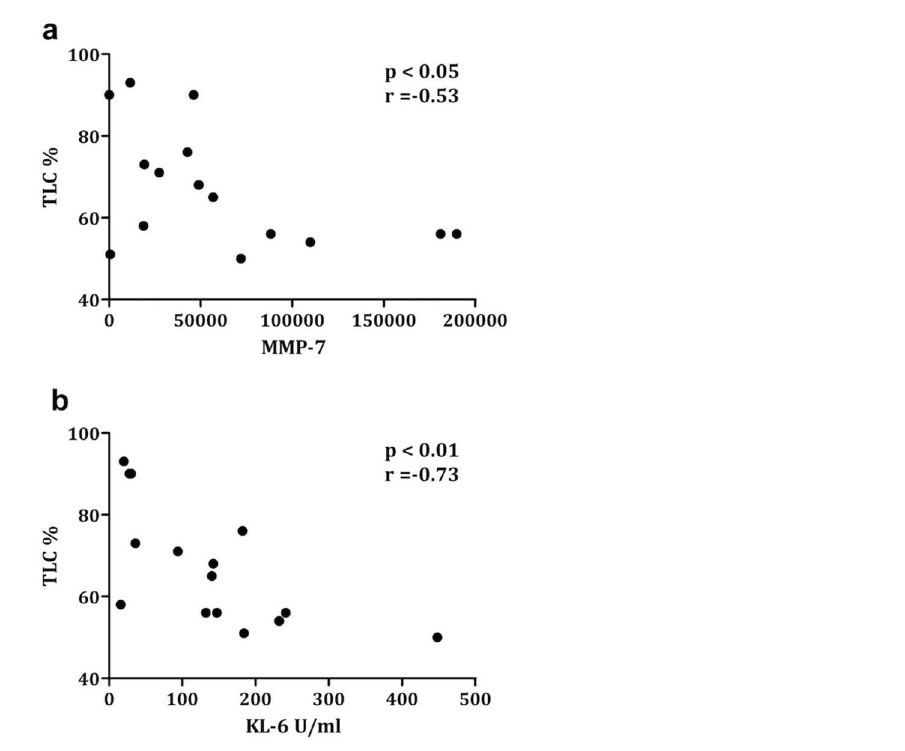
Fig 2. Correlation between MMP-7 and KL-6 and TLC (% pred) in IPF. a) Correlationbetweenlevel of MMP-7 (ELISA) in supernatant of IPF patients and total lung capacity (TLC)(%predicted). b) Correlation betweenlevel of KL-6 (ELISA) in supernatant of IPF and TLC (%predicted).